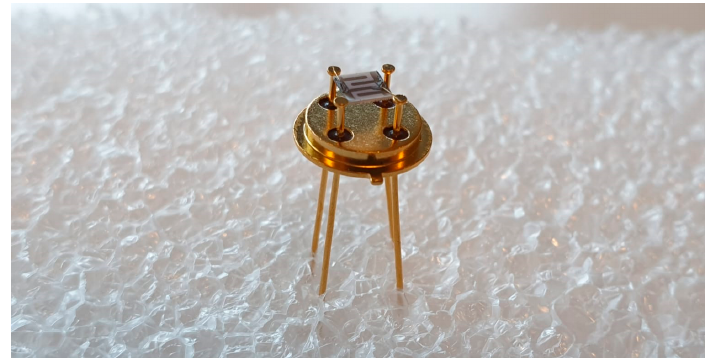
Figure 1. An image of a chitosan@SnO 2 hybrid nanowire (NW) sensor.